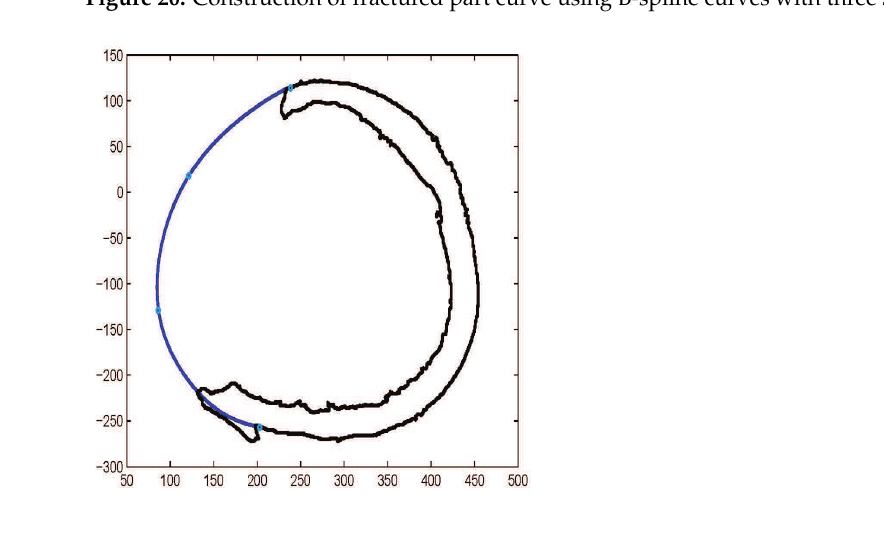
Figure 21. Construction of fractured part curve using NURBS curve with three segments.